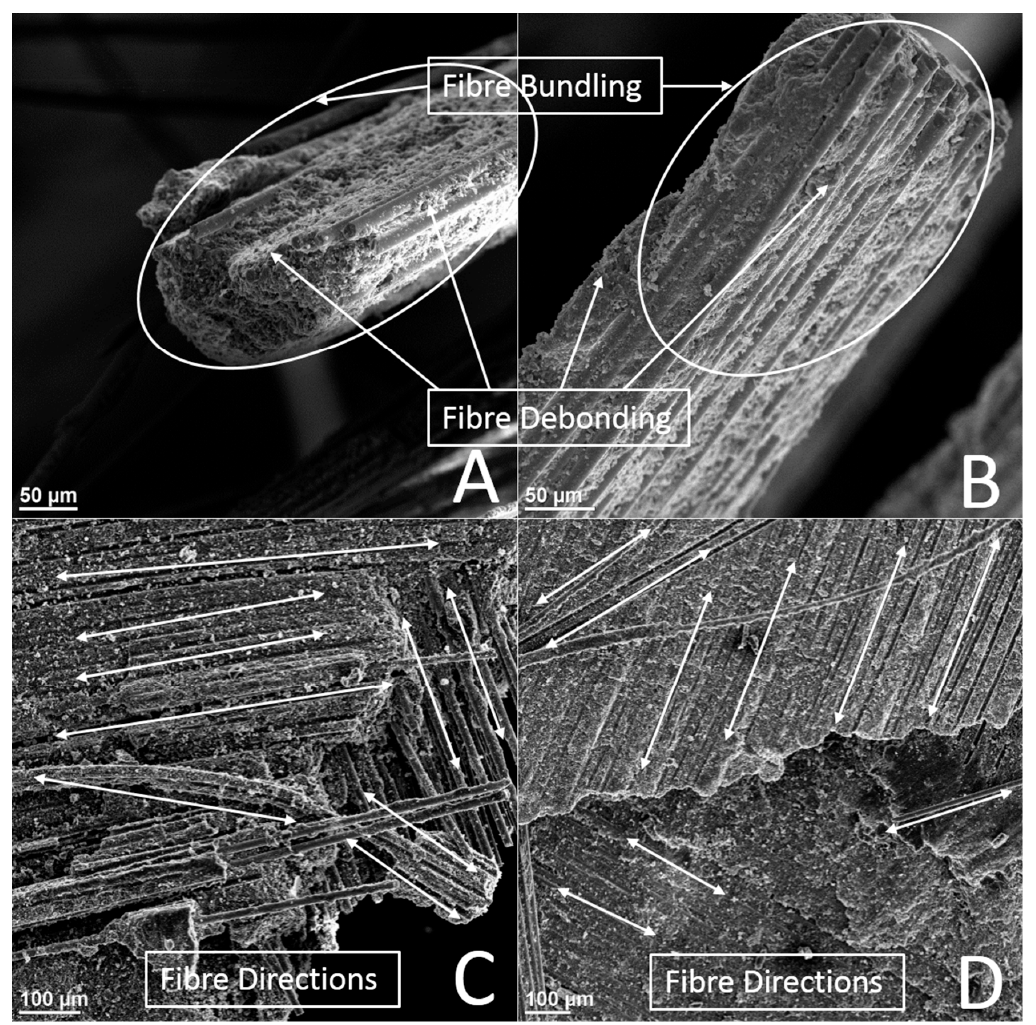
Figure 8. SEM of Flexural ( A ) Fractography 25% VF at 50 μ m; ( B ) Fractography 45% VF at 50 μ m; ( C ) Top Cross-Section 25% VF 100 μ m; ( D ) Top Cross-Section 45% VF 100 μ m.